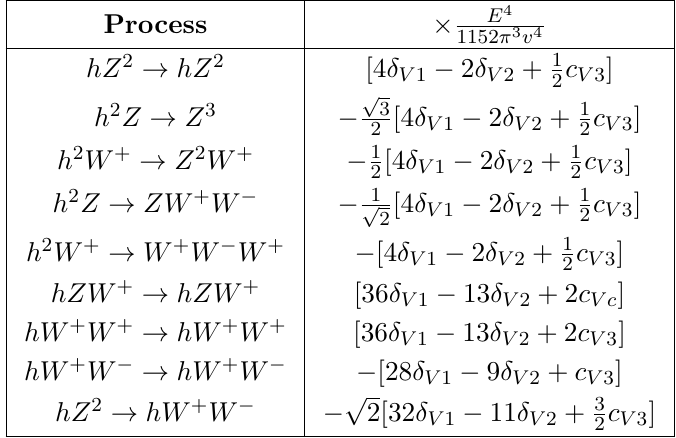
= 4 δ and c = 8 δ gives vanishing amplitudes for all V 2 V 1 V 3 V 1